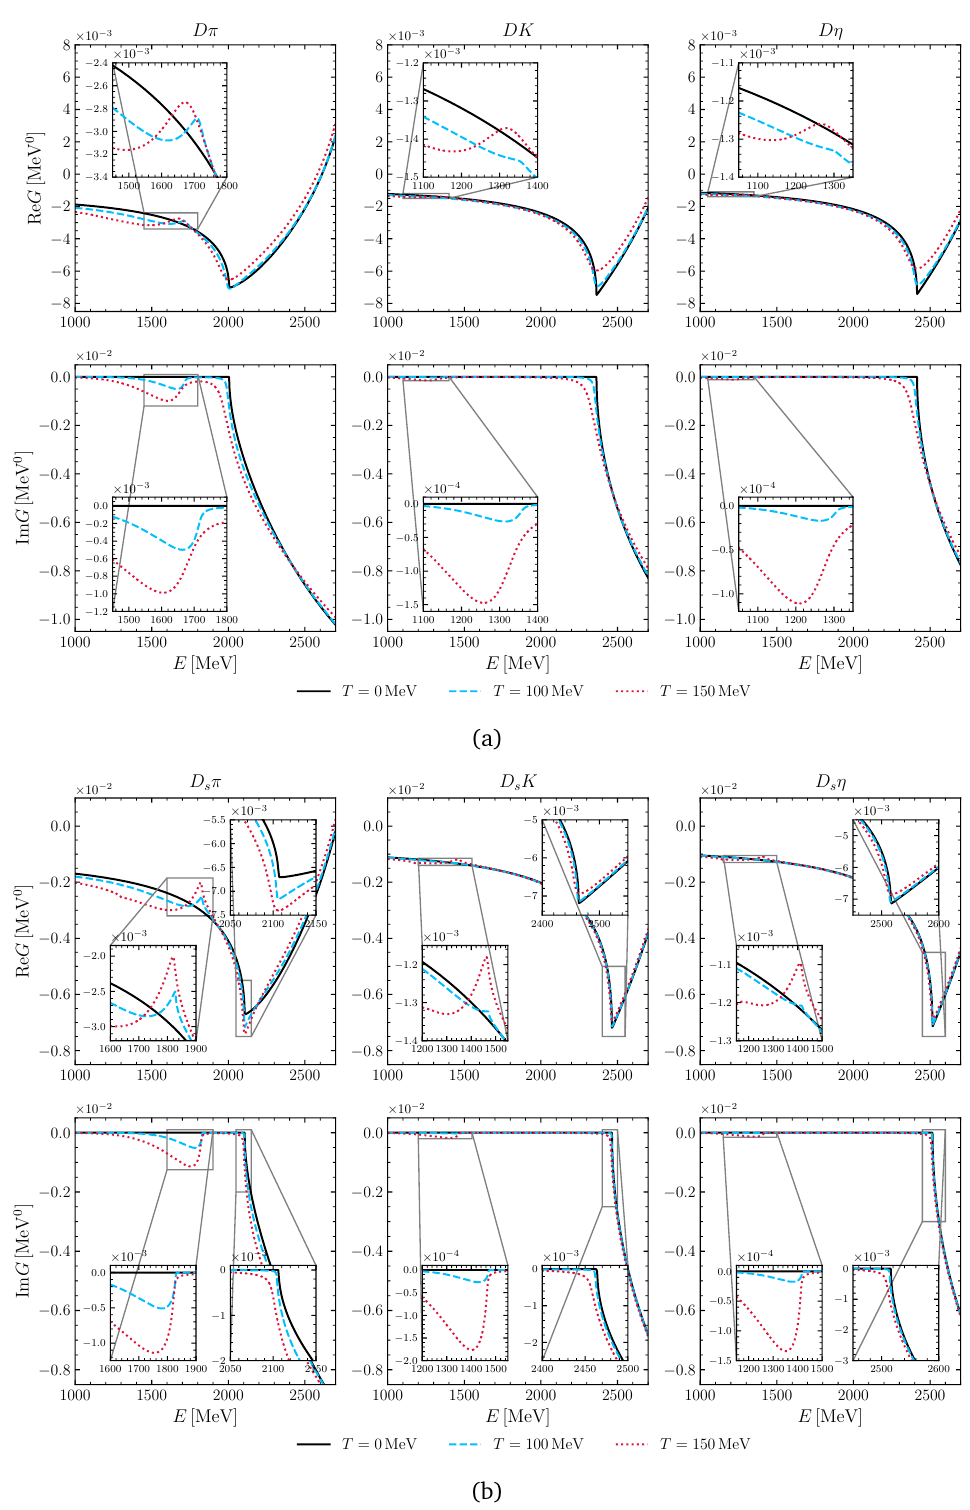
Figure 4: Loop function for channels with (a) a D - or (b) a D meson, the real part in the upper subpanels and the imaginary part in the lower subpanels, at T = 0, 100,